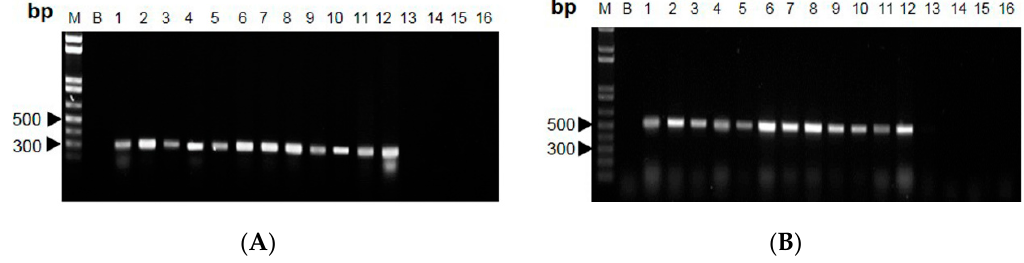
Figure 5. PCR amplification of Cordyceps species using SCAR primers. ( A ) CordySCAR1 and ( B ) CordySCAR2 were used for PCR, and the products were subjected to 1.2% agarose gel. Lane M: 1-kb DNA ladder; Lane B: blank (nuclease-free distilled water); Lanes 1–12: C. sinensis ; Lane 13: C. gracilis ; Lanes 14–15: C. hawkesii ; Lane 16: C. gunnii. Independent experiments were repeated three times, n = 3.